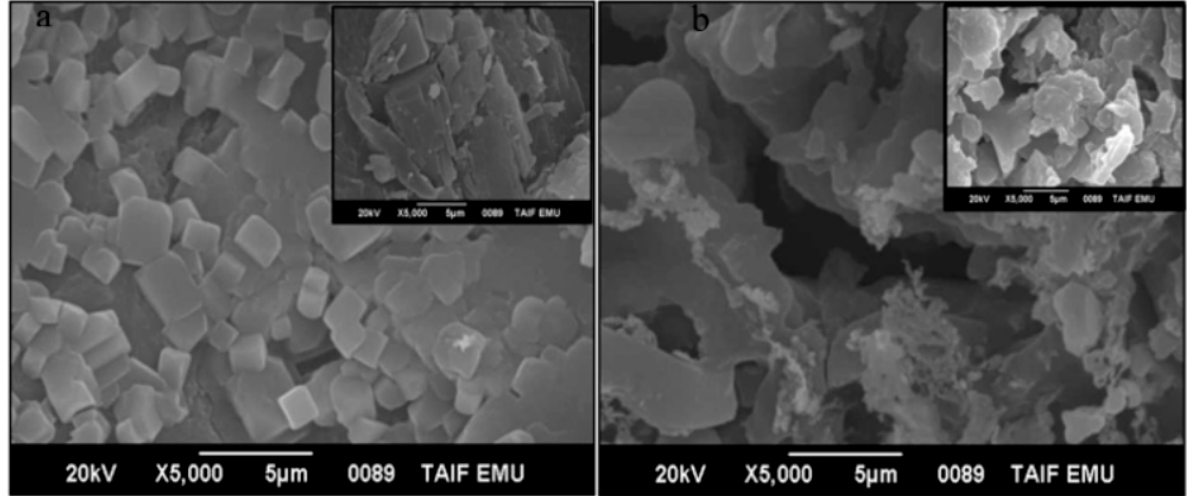
Figure 4. SEM images of ( a ) Ca-Alg 2 nanoparticles (inserted image of Ca-Alg 2 after loading CPT), and ( b ) Ca-Alg 2 -CH nanocomposite (inserted image of Ca-Alg 2 -CH after loading CPT).